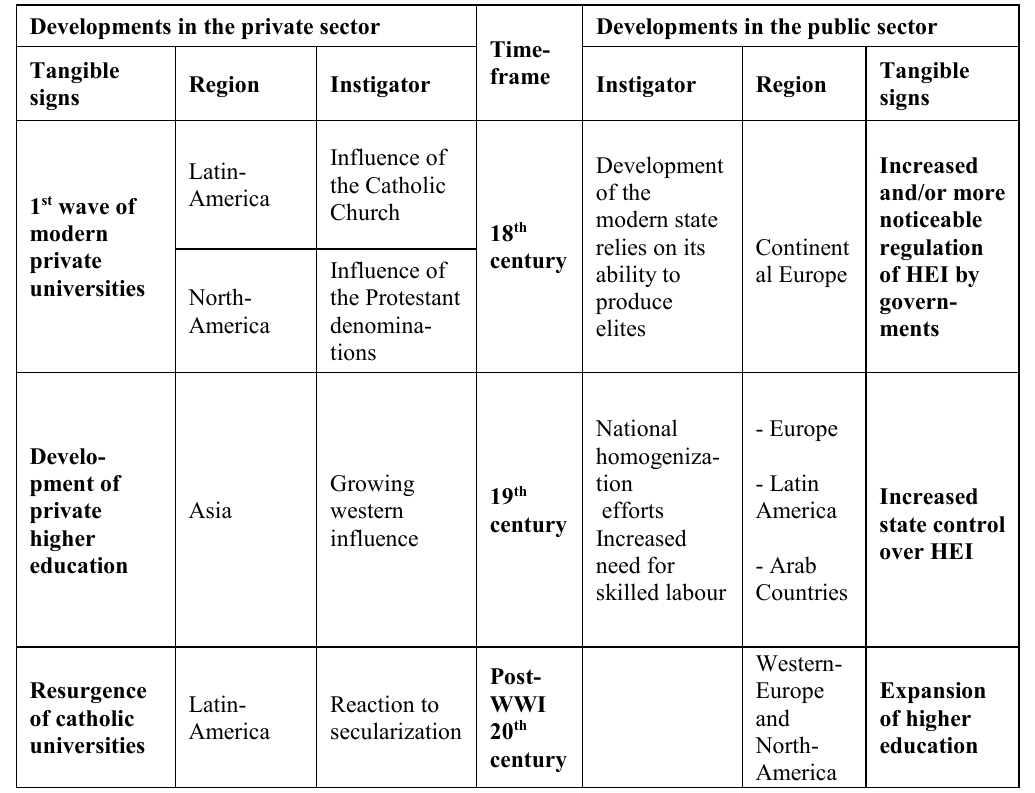
Table 1. Evolution of Public and Private Higher Education Systems (Texeira, 2009, p.